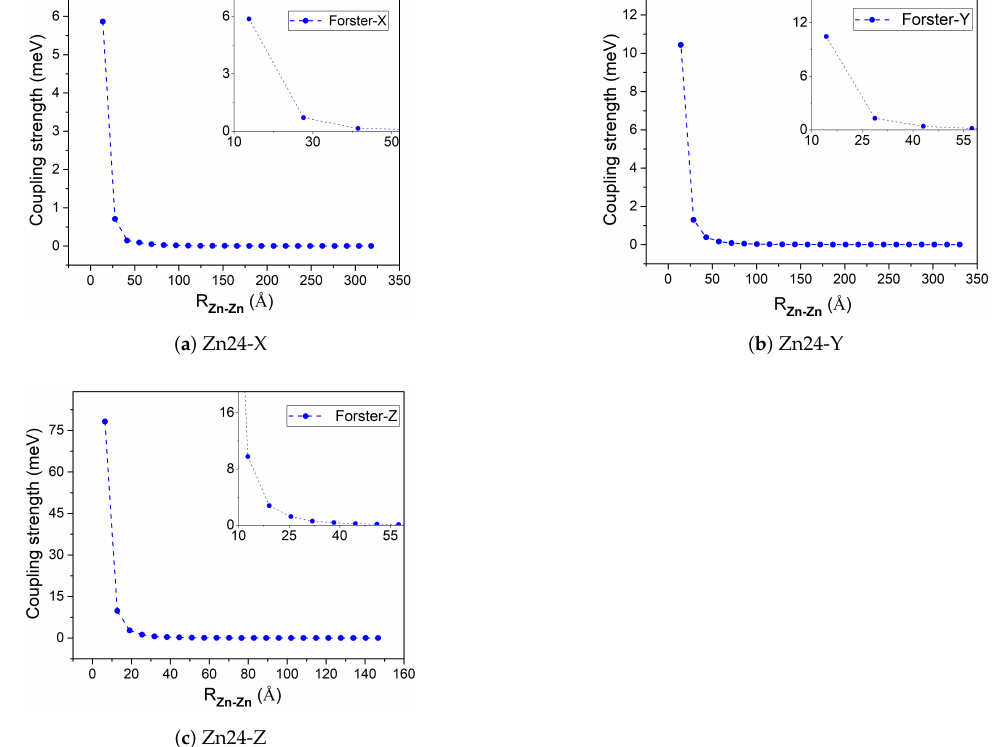
Figure 5. The absolute coupling strength between the first molecule and the remaining 23 molecules in the Zn24-X/Y/Z